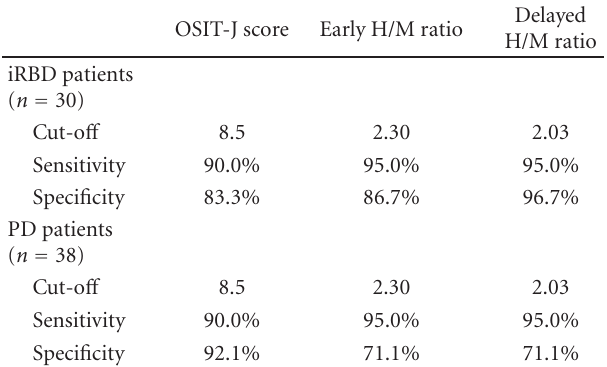
Table 3: Sensitivity and specificity of OSIT-J and cardiac 123 I-MIBG